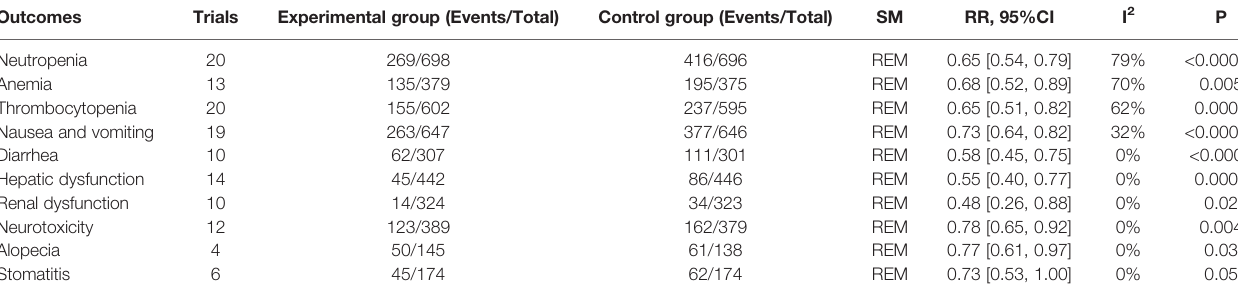
TABLE 2 | Meta-analysis results of adverse drug reactions (ADRs). Outcomes